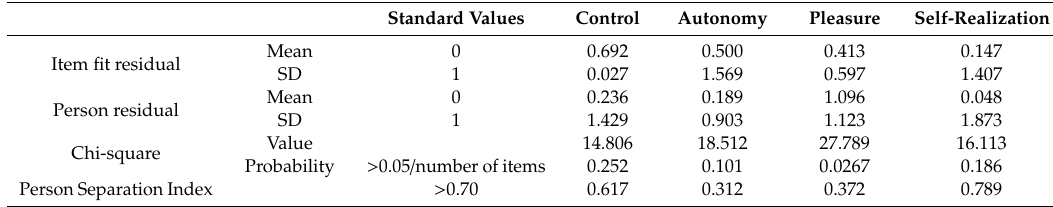
Table 6. Fit of the CASP-12 domains to the Rasch